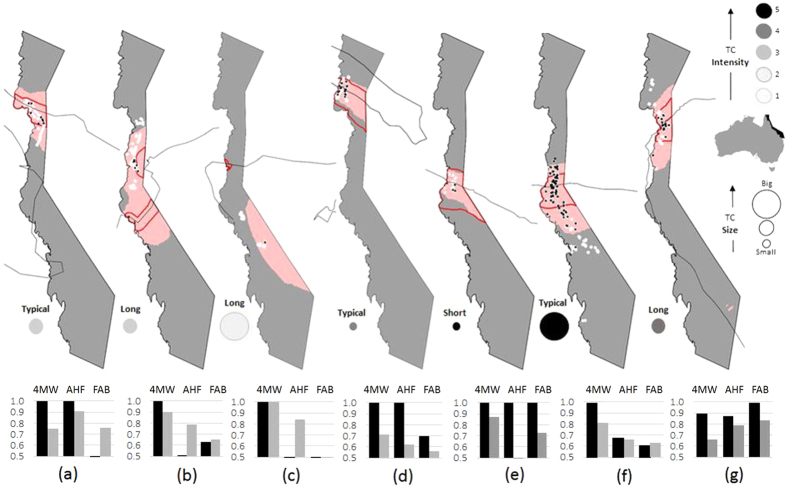
The performance of three models (4MW, AHF, FAB – see Table 1) in predicting severe coral damage in the GBR for 7 TCs for which field data were available: (a) Ivor – 1990; (b) Joy – 1990, (c) Justin – 1997, (d) Ingrid – 2005, (e) Larry – 2006, (f) Yasi – 2011, and (g) Ita–2014.The TC tracked along the thin black line. The 4MW and AHF predicted damage zones are shaded pink and outlined in red, respectively. Field survey sites are shown by black circles (severe damage) and white squares (no severe damage). The true positive rate (how well damage is detected) and overall model accuracy (pAUC) are shown for each model below each map. ArcGIS 10.2 software (https://www.arcgis.com/features/) was used to create the maps.